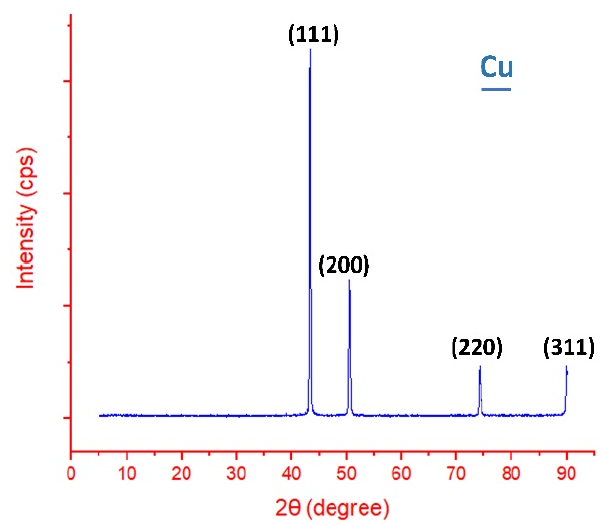
Figure 6. XRD analysis of the fabricated alloy.